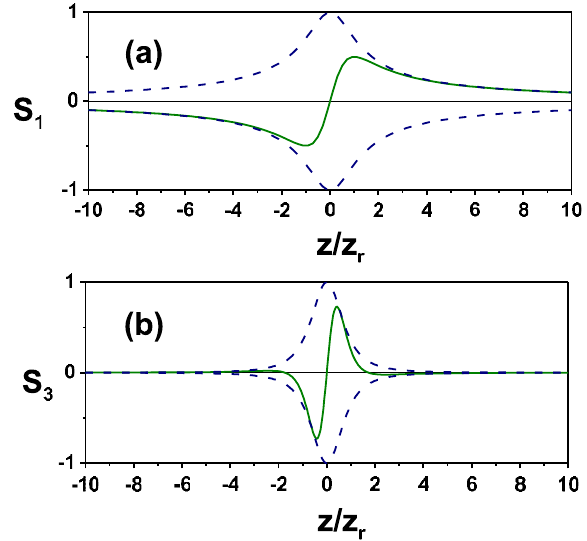
FIG. 4. (a) S 1 and (b) S 3 , described in Eq. (5) when r ¼ 0 and S !t (cid:2) kz ¼ 0 . S 1 is the paraxial field and 3 field and 2nd order field, respectively. The dashed lines indicate (cid:11)ð w 0 =w Þ m . In the the oscillation become shorter than in the paraxial field. When the longitudinal distribution of the field is considered as a FIG. 5. (a) Temporal structure and (b) spectrum of the radia- wiggler, the 2nd order field has a shorter period and radiates tion from the copropagation interaction between a 5 fs FWHM higher energy photons than does a paraxial laser with a beam waist of 5 (cid:1) m and an electron bunch of 200 MeV energy. The laser intensity at focus is 2 : 1 (cid:8) ¼ 10 ). Inset of (a): the radiation power on a 10 20 W = cm 2 ( a 0 log scale. White dashed line: best Gaussian fit with a width of 4.83 fs FWHM. The radiation power and the number of photons shown here are those for 0.5 nC electron bunch, which has been scaled up linearly from the results calculated for smaller number of electrons.